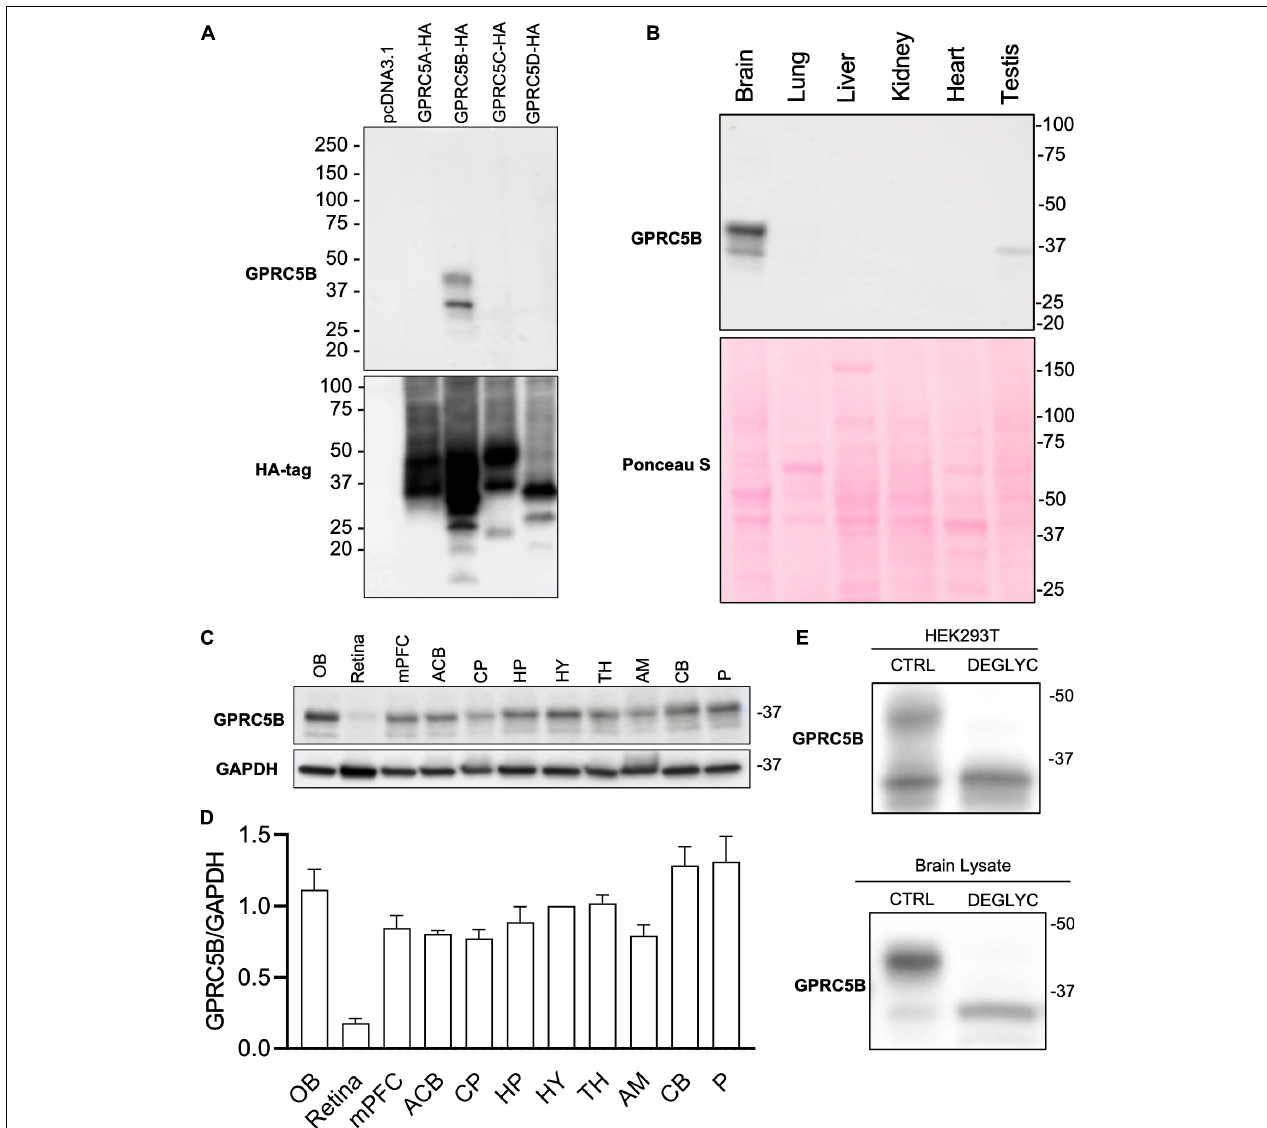
FIGURE 2 | GPRC5B is enriched in the brain. (A) GPRC5B antibodies are highly specific. Western blot analysis of HEK293T cells transfected with constructs expressing HA-tagged GPRC5A, GPRC5B, GPRC5C, and GPRC5D along with empty vector pcDNA3.1 using specific anti-HA antibodies show expression of all the constructs (bottom panel). Western blot using our polyclonal anti-GPRC5B antibodies shows specific signal only in GPRC5B-transfected cell lysates. (B) Western blot analysis of GPRC5B expression in tissue lysate from brain, lung, liver, kidney, heart, and testis. Ponceau S staining was used as a loading control. (C) Brain lysates from different regions were tested for expression of GPRC5B. (D) Quantification of GPRC5B expression levels within different brain regions normalized to GAPDH. (E) Deglycosylation assay on transfected cells (top panel) and whole brain lysate (bottom panel) followed by immunoblot of GPRC5B. Glycosylated